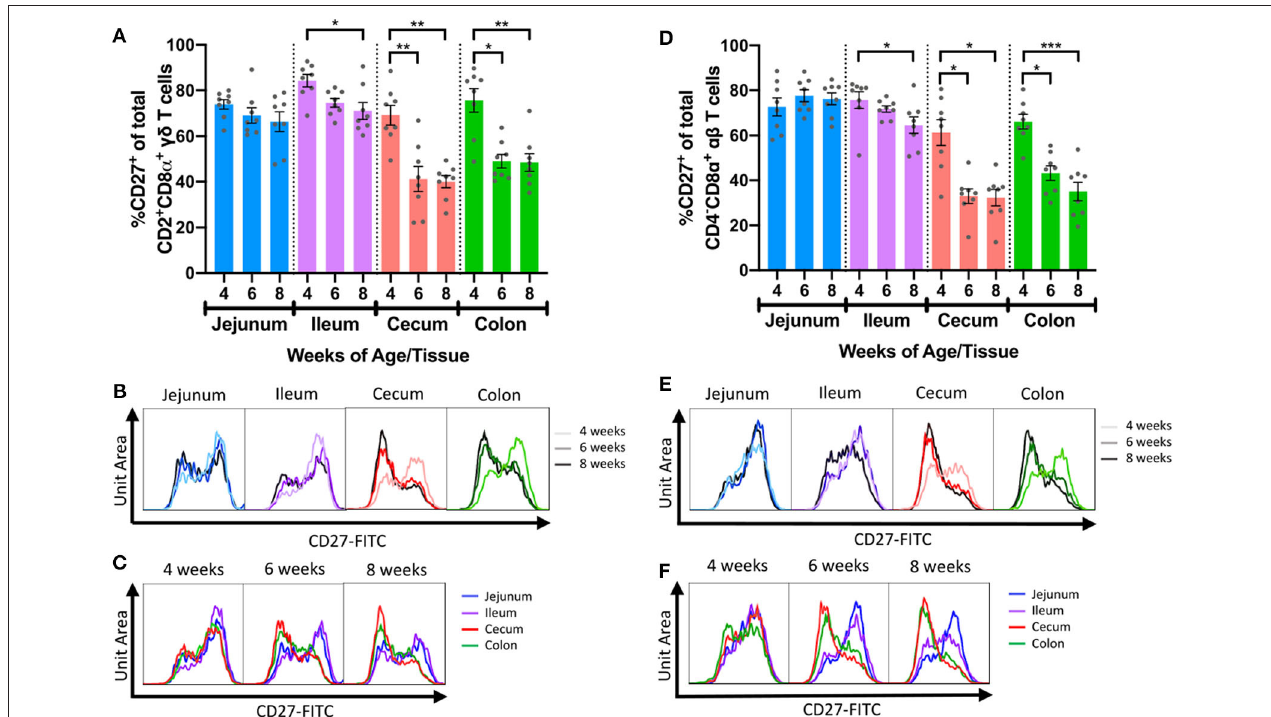
FIGURE 5 | Frequencies of IETs expressing CD27 decreased with age in distal intestinal tract. (A) Comparisons of percentages of CD27 + cells within CD2 + CD8 α + γδ IETs across timepoints within a single intestinal tissue. (B,C) Fluorescence intensities of CD27 from total CD2 + CD8 α + γδ IETs within a single intestinal tissue across time (B) or within a single timepoint across intestinal tissues (C) . (D) Comparisons of percentages of CD27 + cells within CD4 − CD8 α + αβ IETs across timepoints within a single intestinal tissue. (E,F) Fluorescence intensities of CD27 from CD4 − CD8 α + αβ IETs within a single intestinal tissue across time (E) or within a single timepoint across intestinal tissues (F) . In ( B,C) and (D,E) , frequency is proportional to unit area under the curve, and all samples are represented by equal total unit area under the curve. For fluorescence intensity curves, data are from merging the subsetted data of 8 samples from each timepoint/tissue combination used for t-SNE analysis. The same data are presented in B and C or D and E to show age-dependent (B,D) or tissue-dependent (C,E) changes. Statistical significance was determined for percentages of total CD27 + cells within a single tissue across timepoints by the rank-based Kruskal-Wallis test using all combinations of multiple comparisons within a tissue. P < 0.05 were considered significant (* < 0.05, ** < 0.01, *** < 0.001). Samples were taken from four animals per timepoint in each of two separate experiments ( n = 8 per timepoint; n = 24